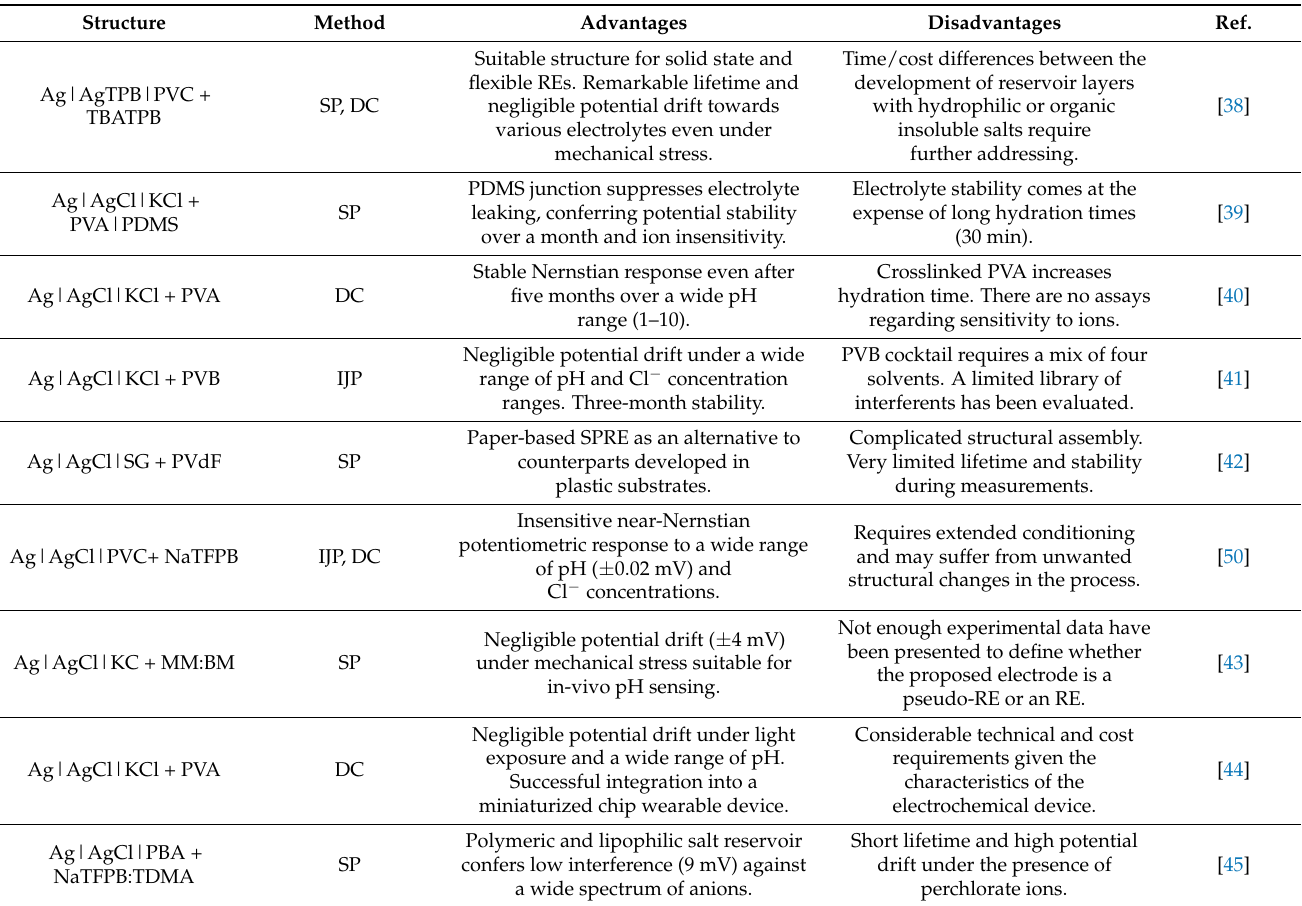
Table 2. Summary of the REs proposed in the recent literature. Notation: AGTPB—silver tetraphenylborate, TBATPB—tetrabutylammonium tetraphenylborate, PVA—poly(vinyl acetate), PDMS—polydimethylsiloxane, SG—silicone gel, PVdF—poly(vinylidene difluoride), MM—methyl methacrylate, BM—butyl methacrylate, PBA—poly(butyl acrylate), NaTFPB—sodium tetrakis